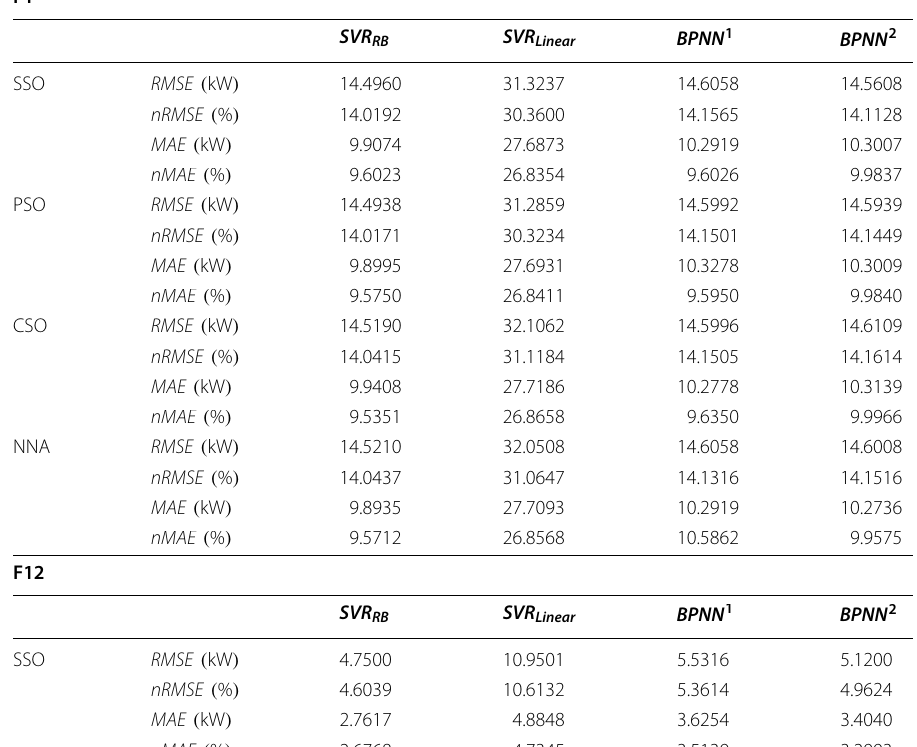
Table 6 The Statistical error results of different sets of feature combinations